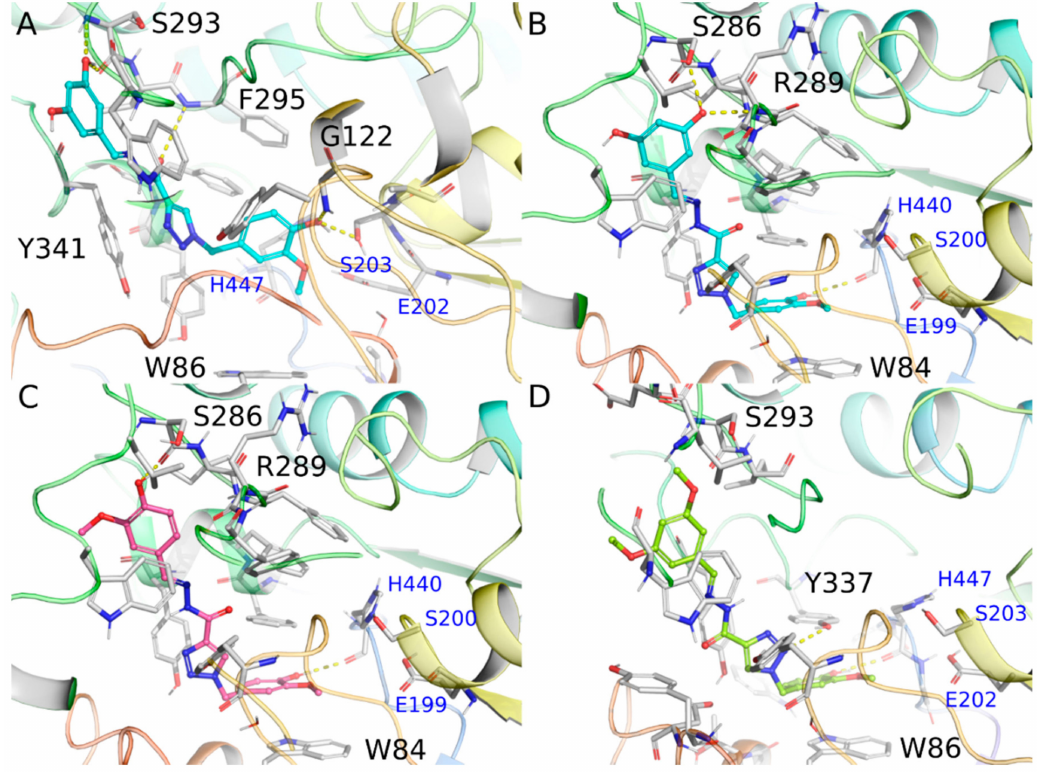
Figure 4. Docking results for compounds 3b complexed with 4EY7 ( A ) and 1ZGC ( B ), 3e complexed with 1ZGC ( C ), and 3d complexed with 1Q84 ( D ). Hydrogen bonds are represented as yellow